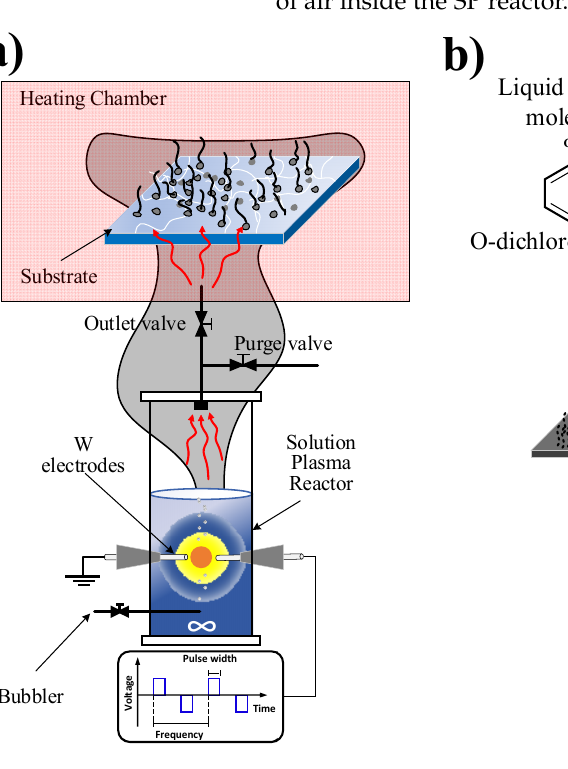
Figure 1. ( a ) Experimental setup consisting of the solution plasma reactor and the heating chamber connected by a gas dispenser system. ( b ) Hierarchical carbon fiber growth and surface modification. Solution plasma was used as the method for supplying the carbon precursor (PGS) and subsequent fiber growth on a Ni substrate. Then, the surface of the fibers was modified to enhance their physical properties for CO 2